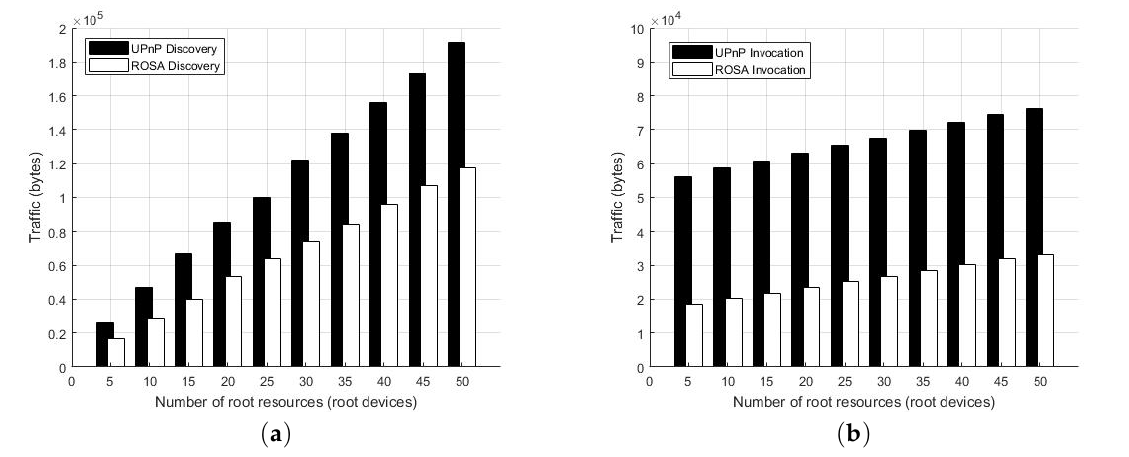
Figure 9. Network traffic generated by UPnP and ROSA. ( a ) Discovery; ( b )